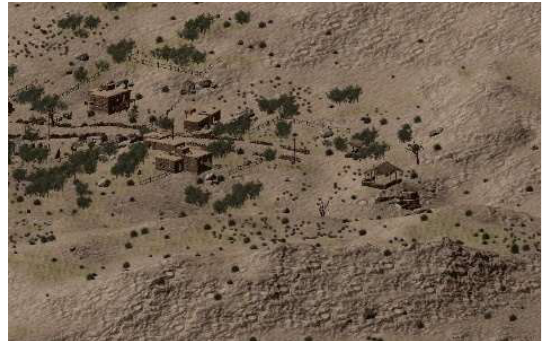
Figure 4. The basic virtual scene.